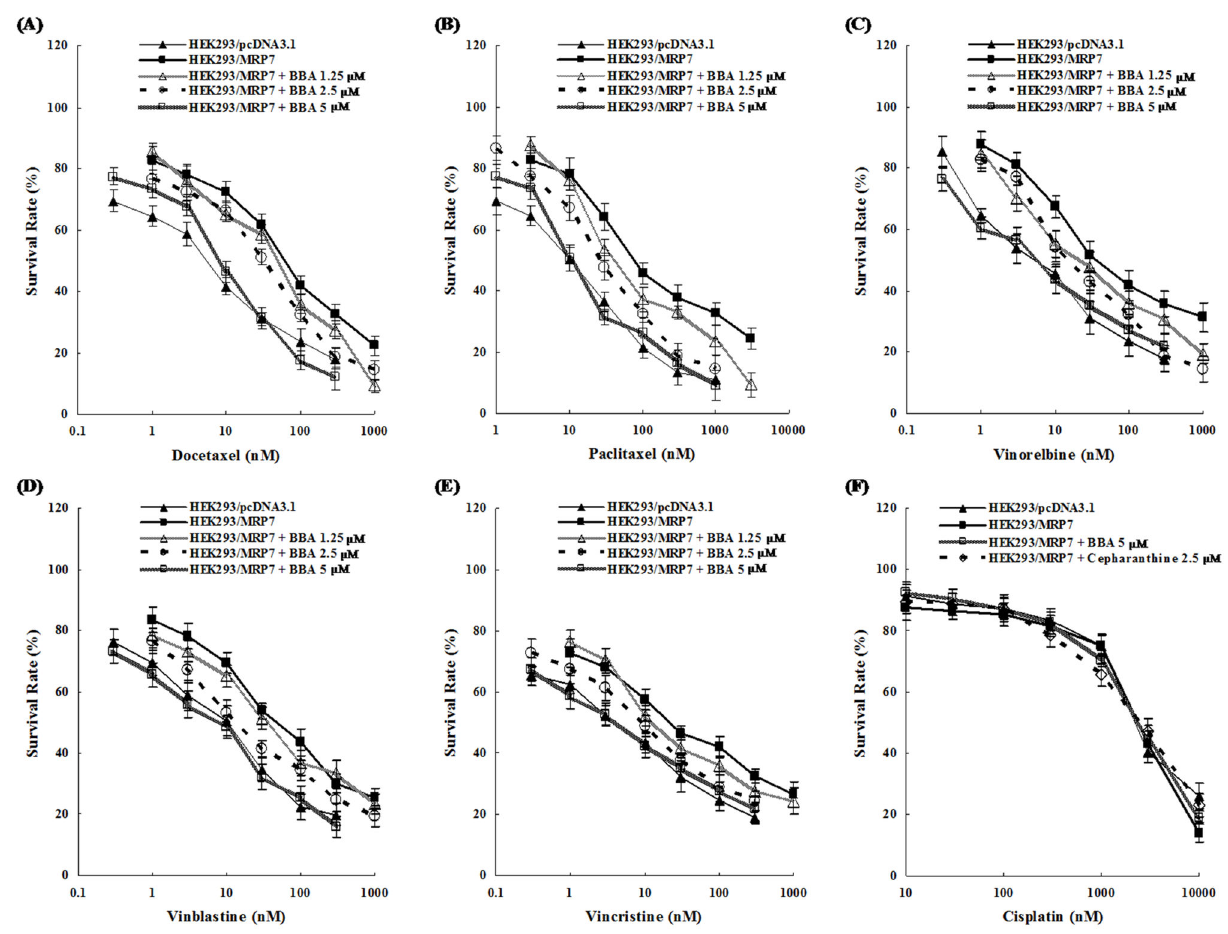
Figure 2. BBA increases the cytotoxicity of anticancer drugs in concentration-dependent manner. Panel A, B, C, D, E, F: the survival curves of parental HEK293/pcDNA3.1 and HEK293/MRP7 cells without reversal agent and HEK293/MRP7 cells in the presence of cepharanthine (a known inhibitor of MRP7) at 2.5 µM or BBA at 1.25, 2.5 and 5 µM at the different concentrations of docetaxel, paclitaxel, vinorelbine, vinblastine, vincristine and cisplatin (a non-substrate of MRP7), respectively. Cell survival was determined by MTT assay as described in “Materials and Methods”. Data are means ± SD of at least three independent experiments performed in